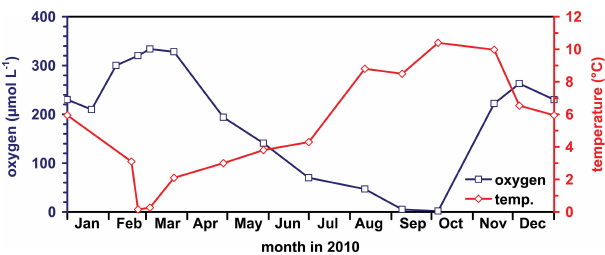
Fig. 7. Time series of temperature and dissolved oxygen in the bot- tom water (25m) measured at Boknis Eck in